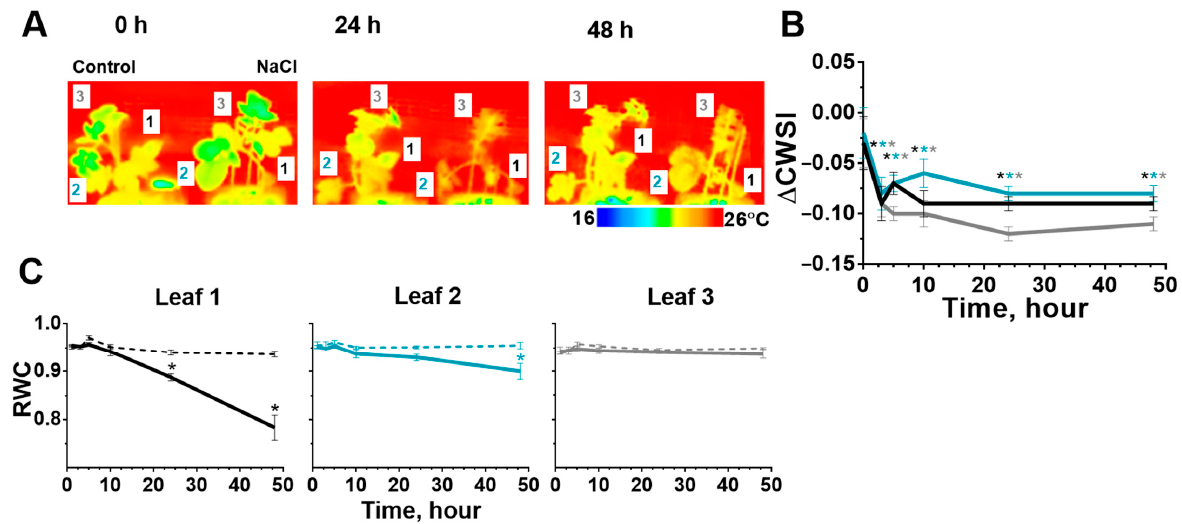
Figure 4. Temperature of potato leaf (1, 2, 3) surface (in at three time points: 0, 24 and 48 h) ( A ), CWSI relative control plant (leaves: 1—black, 2—blue, 3—gray) ( B ) and RWC (control—dotted, salinity—solid) ( C ) changed during salt stress. The data are presented as mean ± SEM (n = 6), * p < 0.05 control versus salt treatment.